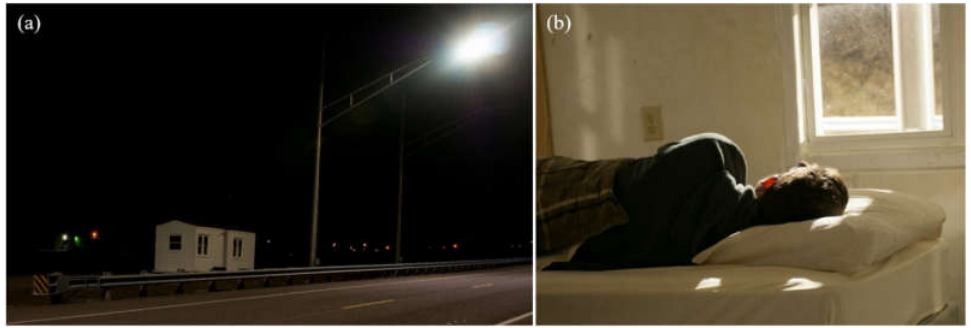
Table 2. Calculated corneal alpha-opic lux values for the five roadway luminaires utilized in the study.